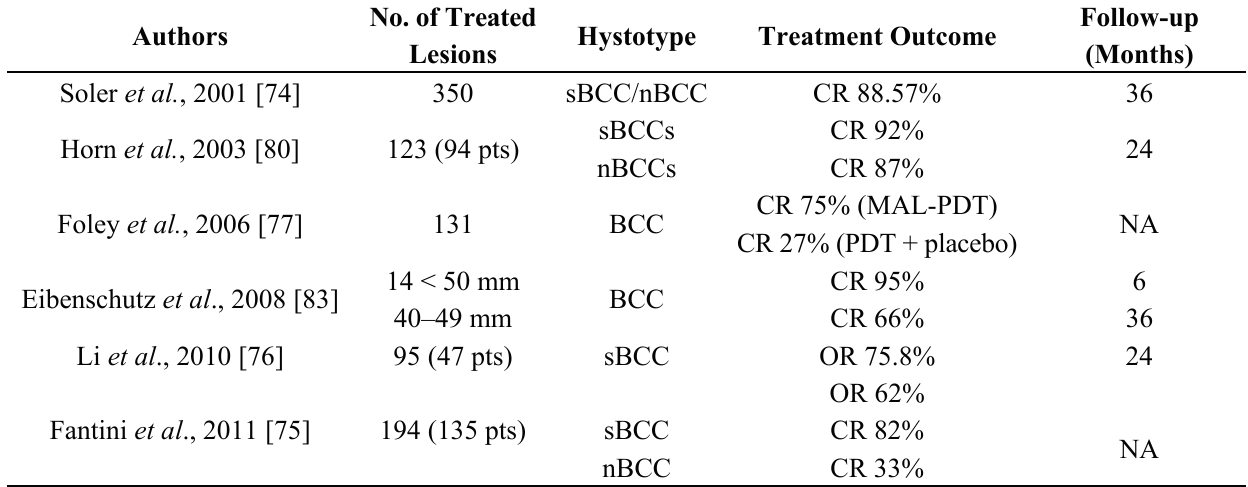
Table 2. Clinical results of MAL-PDT in treatment of